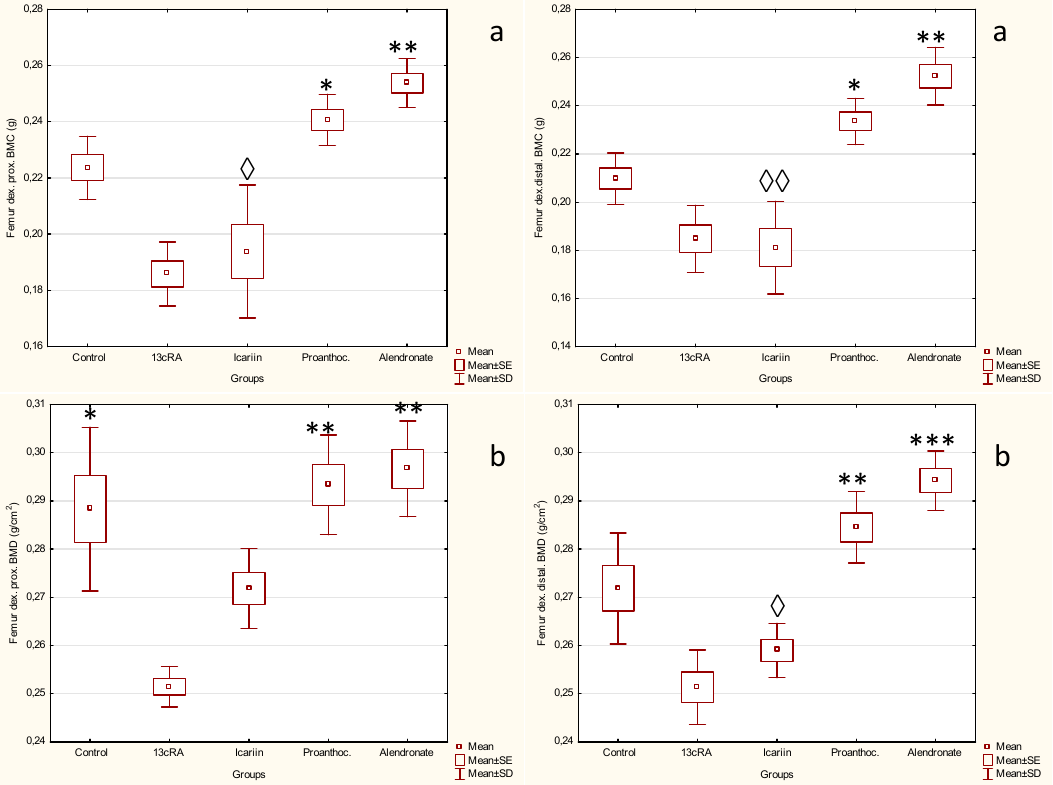
Figure 3. Effect of icariin, proanthocyanidins and alendronate on bone mineral content ( a ) bone mineral density ( b ) in rats with retinoic acid ‐ induced bone loss. Rats were administered ig with retinoic acid suspension (80 mg kg − 1 ) once daily for 14 days. After inducing osteoporosis with 13cRA, rats were administered ig with icariin (100 mg kg − 1 ), proanthocyanidins (100 mg kg − 1 ) or alendronate (40 mg kg − 1 ) once daily for next 14 days. Bone mineral content (BMC) and bone mineral density (BMD) of each rat’s left femur were measured by dual ‐ energy X ‐ ray absorptiometry (DXA). BMD was calculated by the BMC of the measured area and reported as g/cm 3 . Number of rats per group: 7. ( a ) Statistically significant difference exists between: Prox., 13cRA vs alendronate (** p ˂ 0.01), 13cRA vs. proanthocyanidins (* p < 0.05); icariin vs alendronate ( ◊ p < 0.05);.Distal, 13cRA vs. alendronate (** p ˂ 0.01), 13cRA vs. proanthocyanidins (* p < 0.05); icariin vs alendronate ( ◊◊ p < 0.01); ( b ) Statistically significant difference exists between: Prox., 13cRA vs. Control (* p < 0.05); 13cRA vs. proanthocyanidins (** p < 0.01); 13cRA vs. alendronate ( ◊ p < 0.01); Distal. 13cRA vs. proanthocyanidins (** p < 0.01); 13cRA vs. alendronate (*** p < 0.001); icariin vs. alendronate ( ◊ p < 0.05).